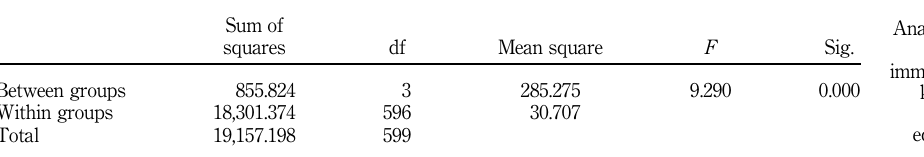
Table III. Analysis of